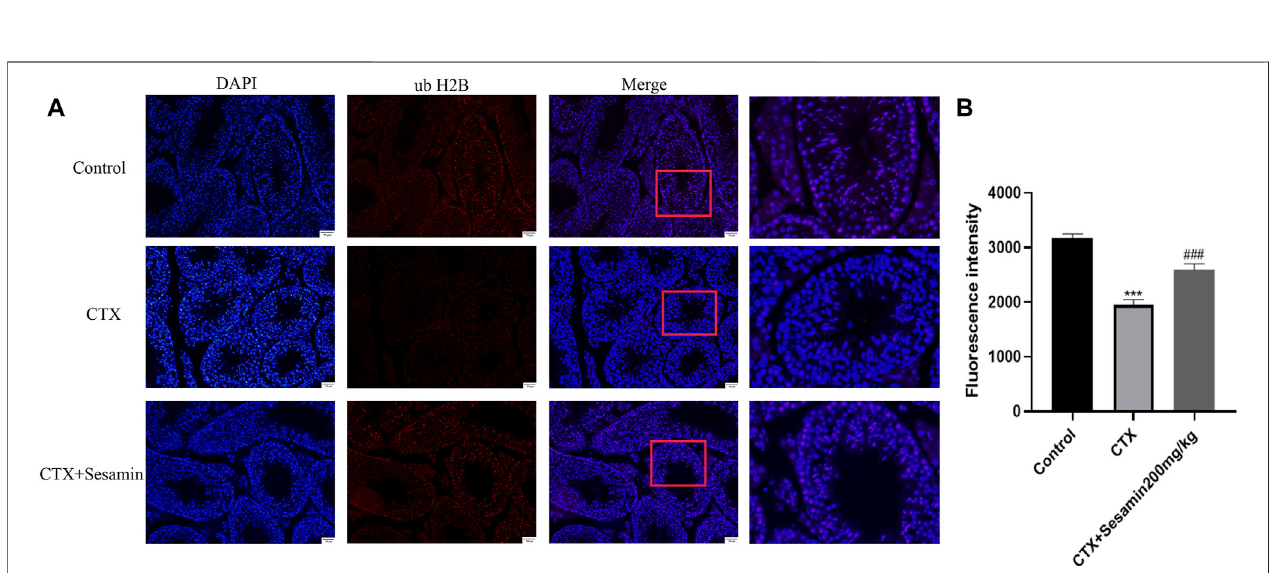
FIGURE 10 | The expression of ubiquitin histone H2B in the testis. The representative fl uorescence photomicrographs of the seminiferous epithelium cycles of the testis at 200 × magni fi cation (scale bar (cid:2) 50 μ m). (A) Theimmuno fl uorescence analysisofubiquitinhistone H2Bin theseminiferoustubuleat stages Ⅺ – Ⅻ . (B) Statistical analysis of the fl uorescence intensity of ubiquitin histone H2B in the different groups. The data indicate the mean ± standard error (n (cid:2) 6). *** p < 0.001 vs. the control group; ### p < 0.001 vs. the CTX group.